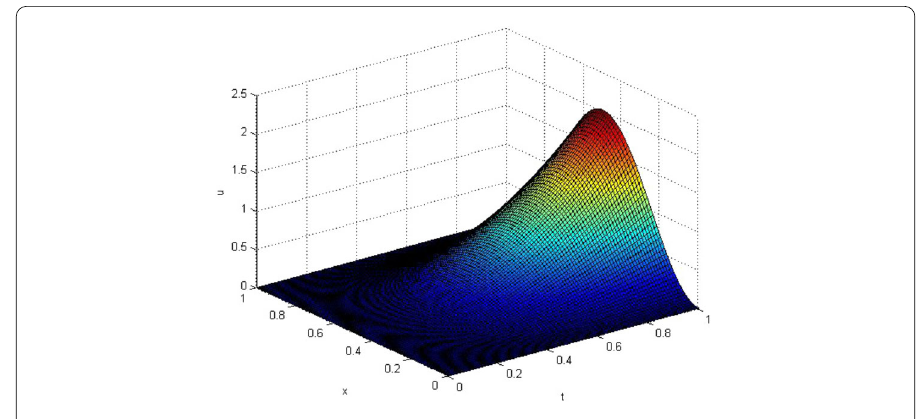
Figure 2 The approximation solution to problem (81)